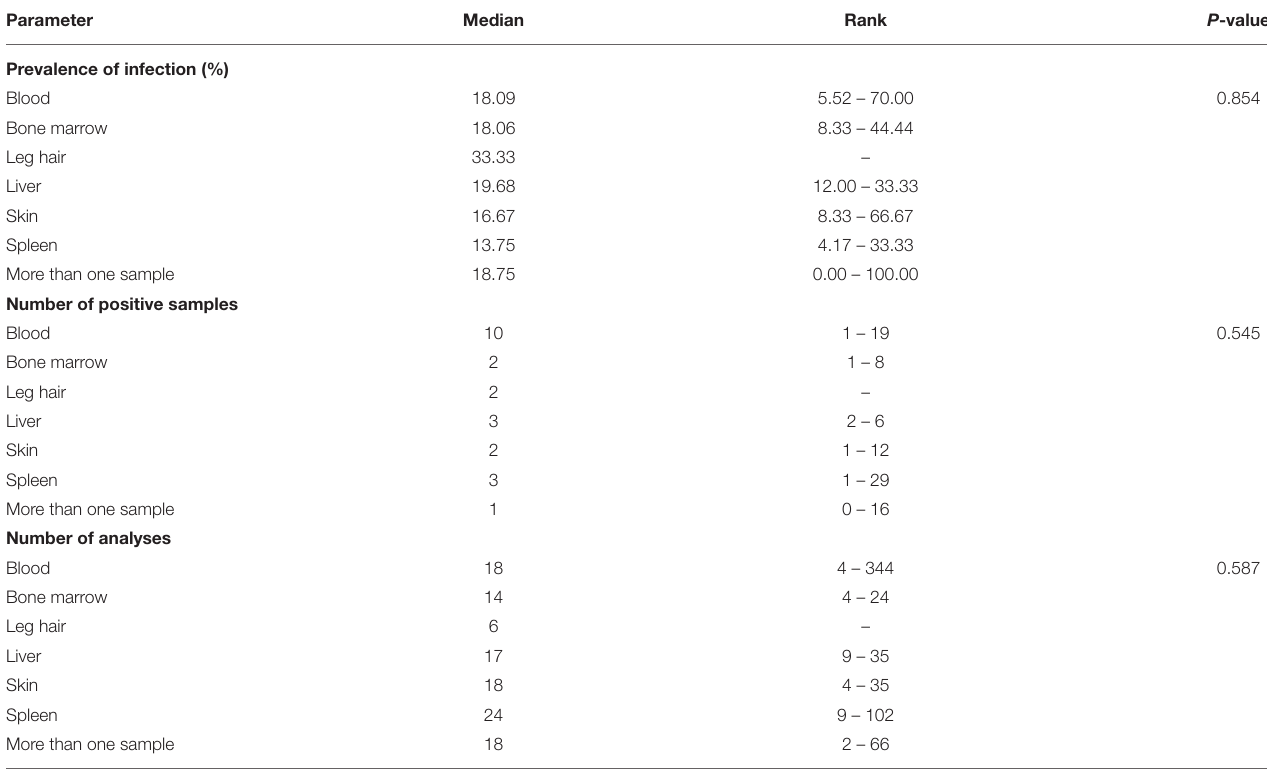
TABLE 4 | Median and rank of infection prevalence in the different tissue samples analyzed, the number of positive samples and th number of analyses in Southern Europe between January 2001 and December 2020. Parameter Median P -value Prevalence of infection